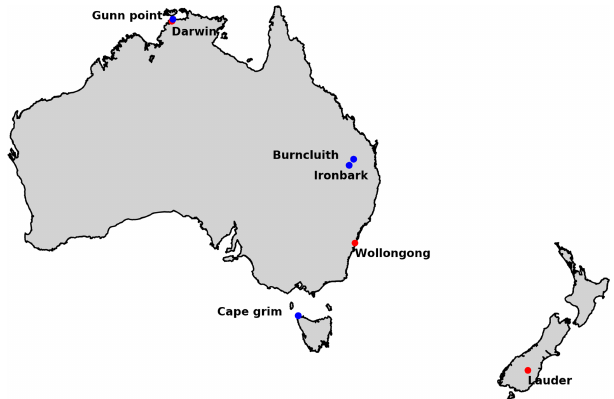
Figure 3. TCCON and in situ location sites. Red dots indicate TC- CON locations. TCCON Darwin and Wollongong are located over Australia, while TCCON Lauder is located in New Zealand. Blue dots represent in situ location around Australia (Gunn Point, Burn- cluith, Ironbark and Cape